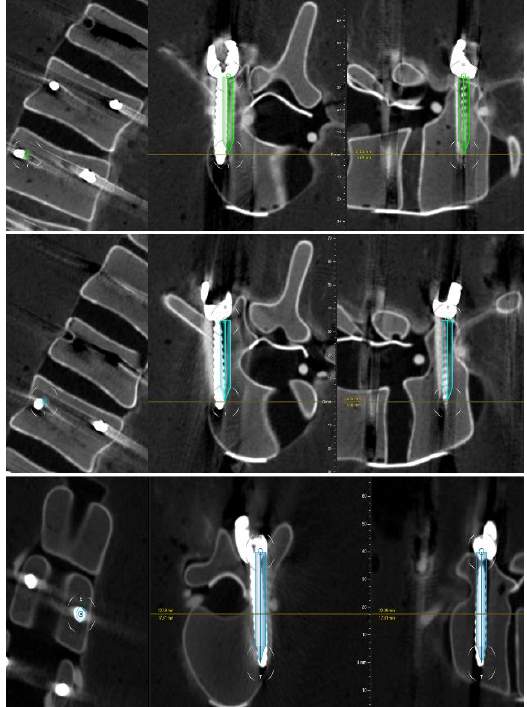
Figure 8. The postoperative scans including the surgical plan for the 3 screws graded 2 on the Gertzbein scale, presented in coronal, axial and sagittal views.